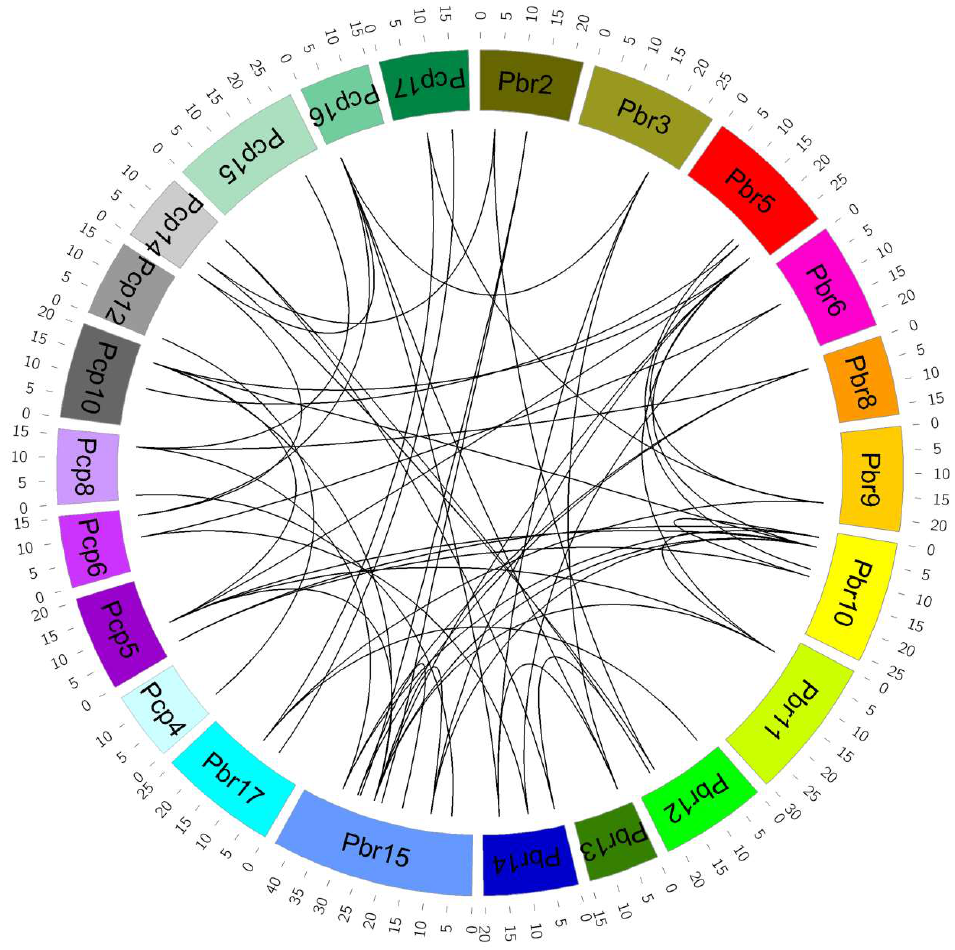
Figure 4. Microsynteny of VQ motif-containing genes across P. bretschneideri and P. communis . The outermost scale represents the megabases (Mb). The P. bretschneideri and P. communis chromosomes are represented by different color boxes and are labeled Pbr and Pcp, respectively. The syntenic relationships are represented by black lines. Remarkably, because PbrVQ35 , PbrVQ36 , PbrVQ37 , PbrVQ38 , PbrVQ39 , PbrVQ40 , PbrVQ41 , PcpVQ27, and PcpVQ28 were located on the scaffold, the